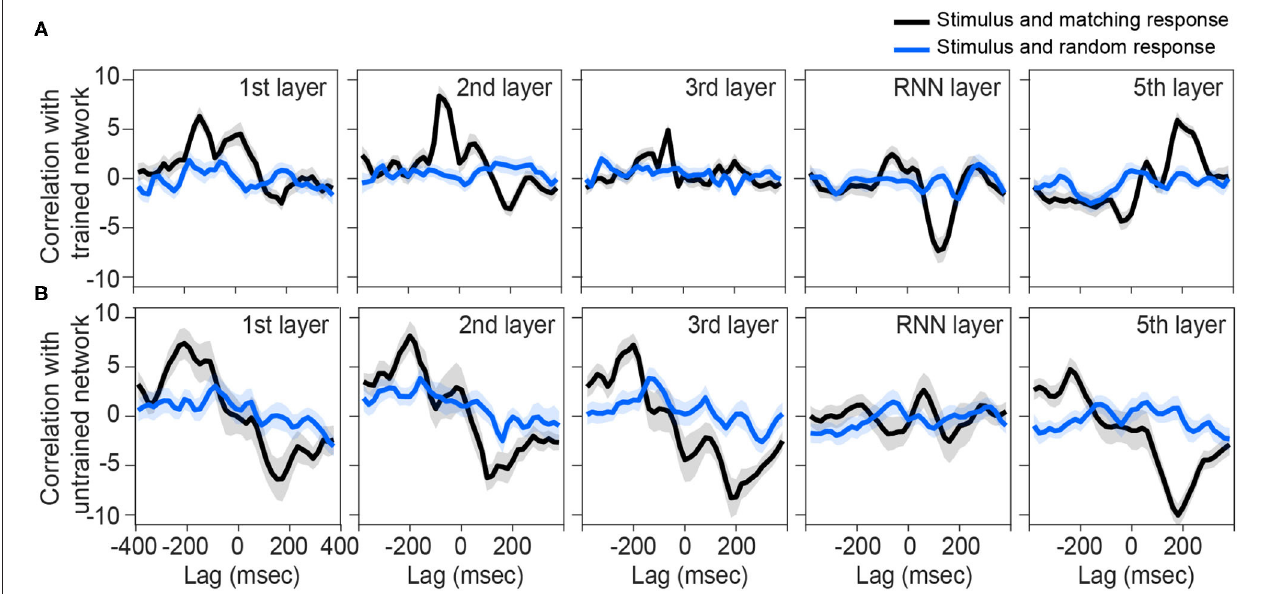
FIGURE 3 | Correlation between preprocessed envelope of stimuli and the output of each layer. Correlation function between half-wave positively rectified deviation of the speech envelope and each layer output of the (A) trained network and (B) each 100 shuffle untrained network are calculated, then averaged across the nodes in the highest 80 percentile. For (B) , correlation functions were then averaged across the shuffles. Solid lines indicate grand mean across the stimuli and their surrounding shadow indicates the Standard Error of Mean (SEM). Black line indicates the correlation between matching pairs of stimuli-output signals, while blue lines indicate random pairs of stimulus and output. All the signals were time-aligned to the stimulus onset; thus, the positive lags represent the delayed responses to the stimulus and negative lags indicate possible network predictions of the future input